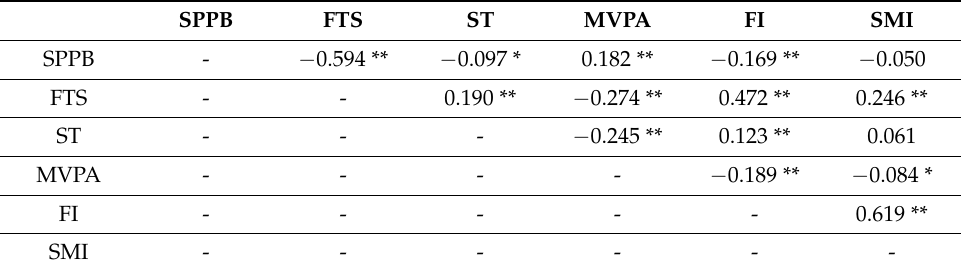
Table 2. Partial correlation coefficients among physical function, frailty, movement behaviors and body composition, corrected for age, sex and educational